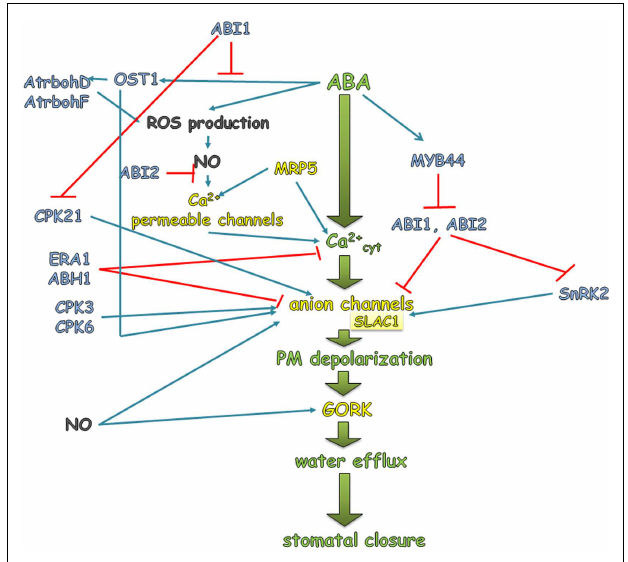
FIGURE 5 | Me-JA regulated stomatal closure during drought stress . MeJA, before it can be bound by a receptor in the plant cell, is converted into a biologically active form ( + )-7-iso-Jasmonoyl-L-isoleucine (JA-Ile). JA-Ile is then bound by the receptor SCF COI complex that contains the coronatine insensitive1 (COI1) F-box protein.This interaction leads to the JAZ degradation which is negative regulator of MYC2. Inactive JAZ is not able to repress MYC2 function which in turn activates JA-responsive genes. MeJA induces the formation of ROS and NO, which activate the efflux of Ca 2 + from internal stores and the influx from the apoplast by channels in plasma membrane. CPK6 acts downstream of NO and ROS signaling and therefore may be the target of an NO-stimulated influx of Ca 2 + into the cytoplasm. As a feedback loop, MeJA-induced influx of Ca 2 + into the cytoplasm activates CPK6, which in turn is able to activate the S-type anion channel – SLAC1, which then leads to the MeJA-stimulated stomatal